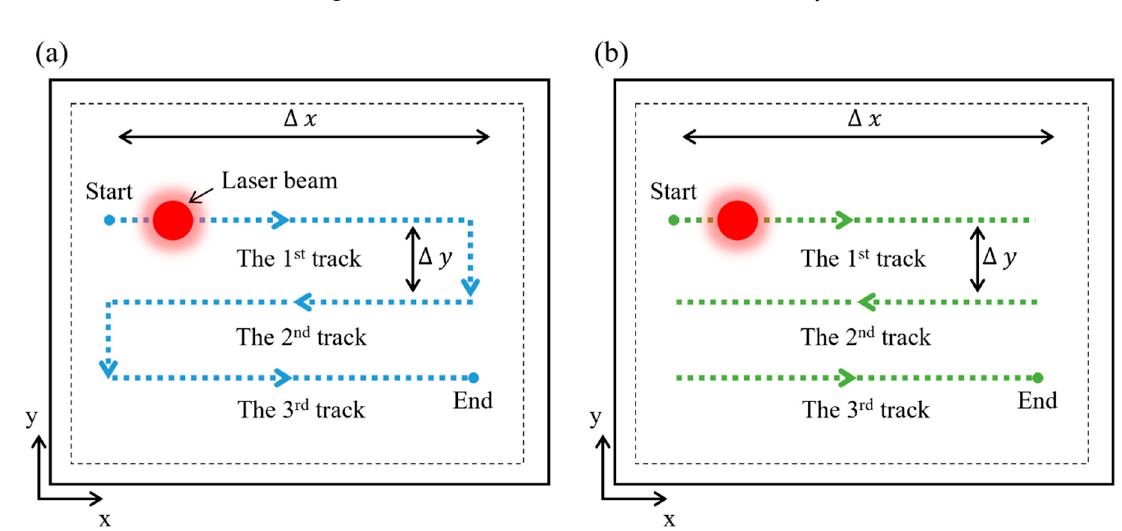
Figure 2. Scanning patterns used in simulation: ( a ) zig-zag pattern and ( b ) bidirectional pattern.